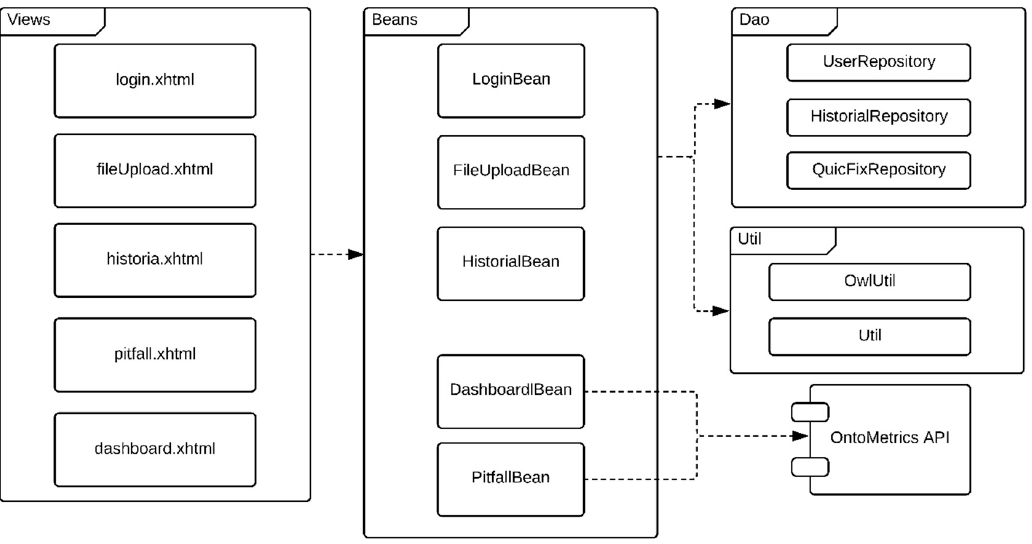
Figure 4. Model View Controller design.